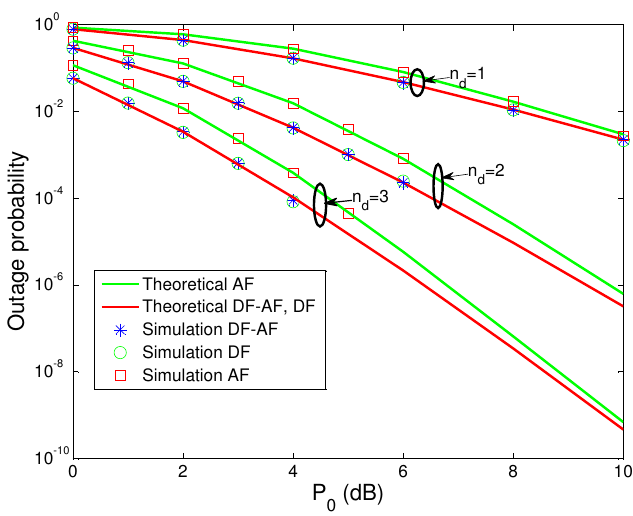
Figure 3. Outage performance of DF-AF selection MIMO relaying, DF MIMO relaying, and AF MIMO relaying with different values of n . d